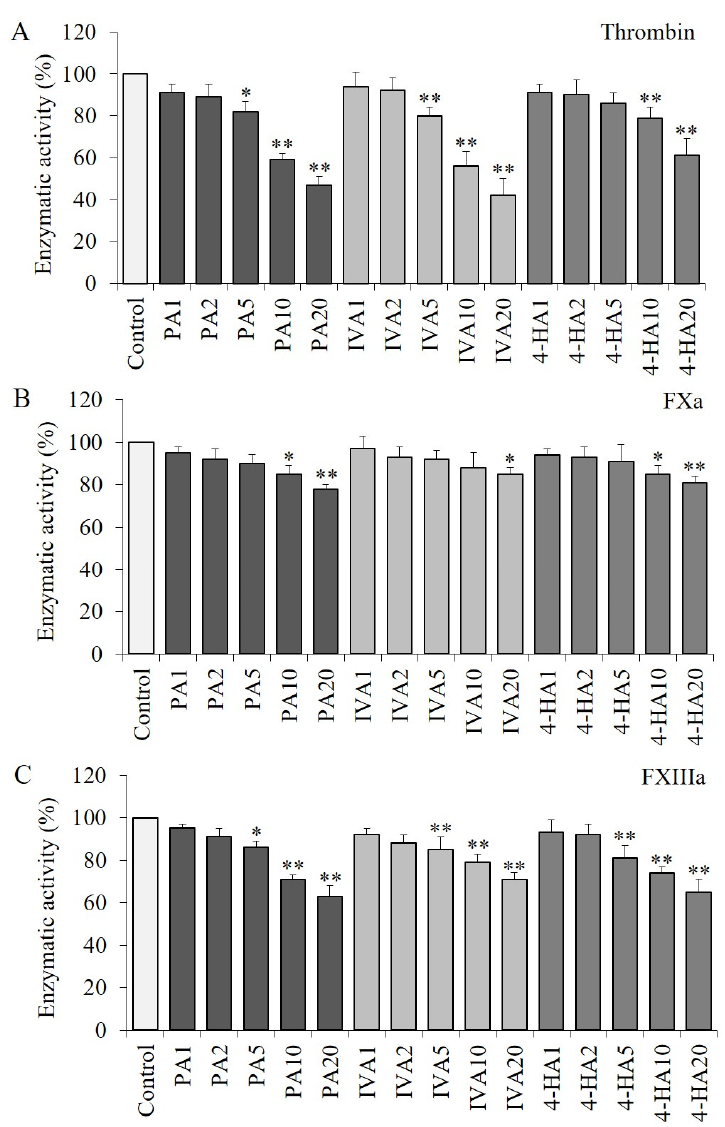
Figure 3. Effects of PA, IVA, and 4-HA on thrombin ( A ), FXa ( B ), and FXIIIa ( C ) activity. Each value is the mean ± SD of triplicate measurements. * p < 0.05 and ** p < 0.01, compared to each control groups. Control, enzyme only; PA1–20, 1–20 μg of PA treated; IVA1–20, 1–20 μg of IVA treated; 4-HA1–20, 1–20 μg of 4-HA treated.